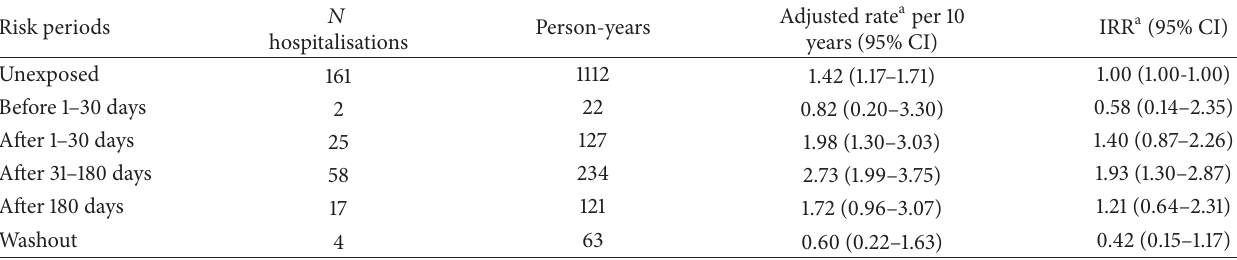
Table 2: Self-controlled case series results for patients with a hospitalisation for bradycardia and at least one dispensing of timolol. Risk